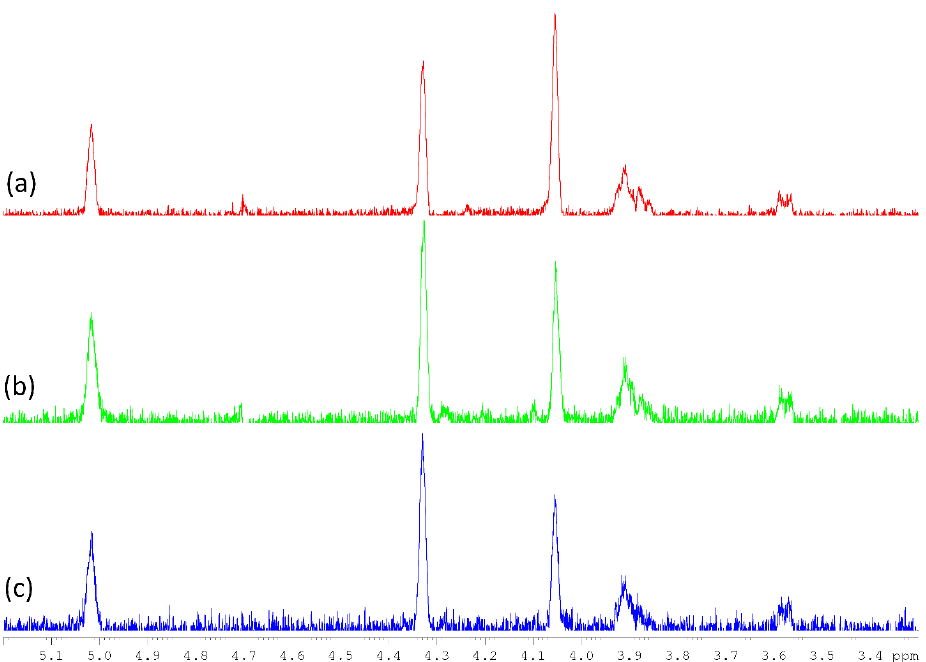
Figure 5. 1D-TOCSY spectra of IPSsb0–2.5 HW ( a , red), F-Chaga HW ( b , green), and Heart Rot HW ( c , blue). NMR spectra were recorded in D 2 O at 308 K, with an irradiation frequency of 5.02 ppm. See Table 2 for signal assignments. The presence of 3-O-Me-Gal in the fraction hydrolysates was highlighted by GC-MS and quantified with GC-FID. Moreover, the superimposition of the collected HSQC spec- tra also showed the presence of the mycelial β-glucan signals in the birch heart rot frac- tions, particularly in Heart Rot HW (Figure S1). The superimposition of the anomeric re- gions of Heart Rot HW, IPSsb0–2.5 2%, and standard galactoglucomannan is reported in Figure S2. A comparison of the 1D-TOCSY spectra (4.55 ppm irradiation frequency) of Heart Rot HW and F-Chaga HW is reported in Figure S3. The intensity of the O-substi- tuted H3/C3 of the mycelial β-glucan (3.53/75.8 ppm) in the HSQC spectrum of Heart Rot